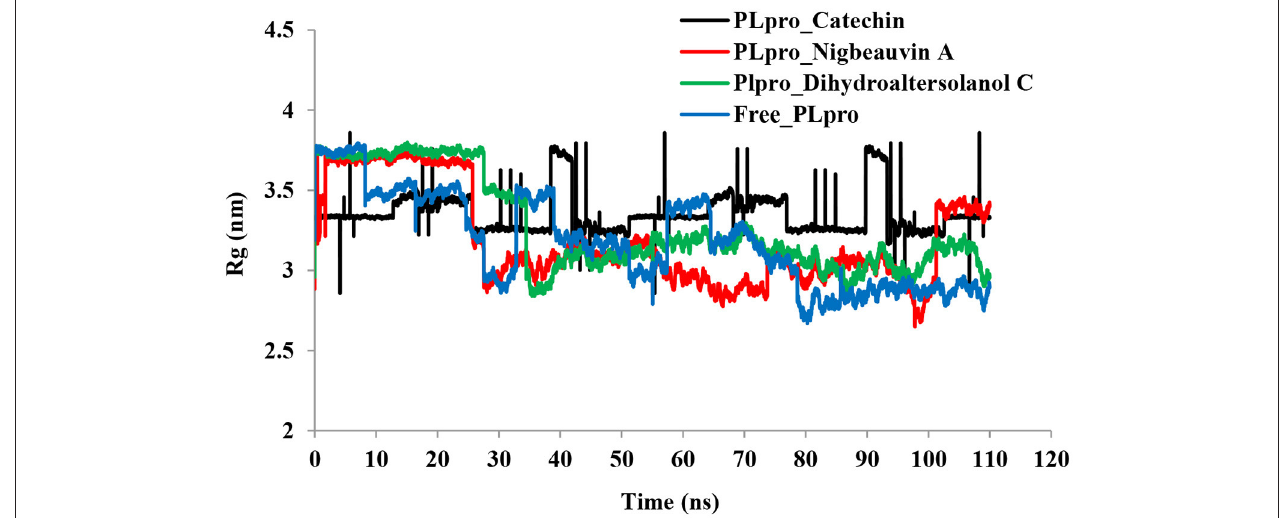
FIGURE 3 | Time series for the degree of rigidity and compactness analyses for the PLpro-ligand complex and Free-PLpro backbone of atoms simulated. PLpro-Catechin code: black, PLpro-Nigbeauvin A code: red, PLpro-Dihydroaltersolanol C code: green, and Free-PLpro code: blue.